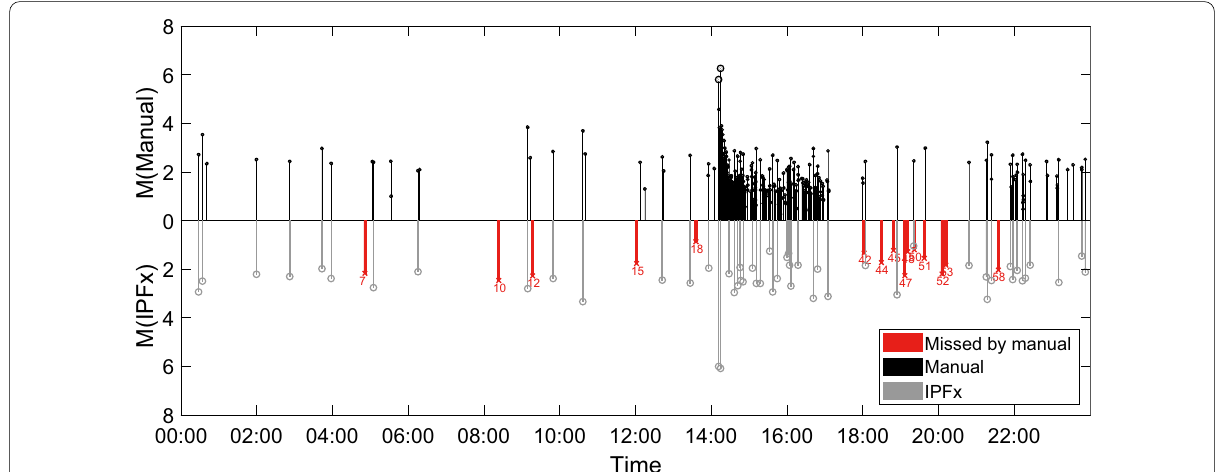
Fig. 9 Time frame of the earthquakes detected by the IPFx method (bottom) and CWB manual catalog (top). The open circles of the CWB manual catalog indicate the earthquakes exceeding the public warning threshold. The red bars indicate the earthquakes detected by the IPFx method that were not on the CWB manual catalog. The red numbers show the sequential ID number of the earthquakes. The waveforms of these events are shown in Additional file 1: Fig. S1